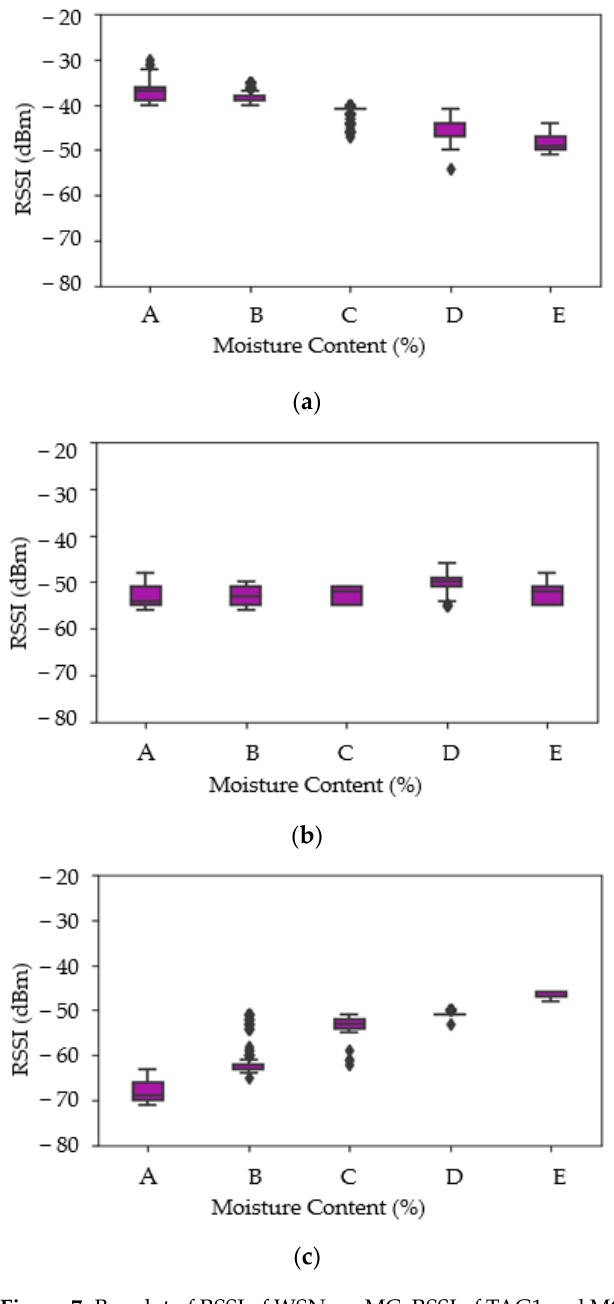
Figure 7. Boxplot of RSSI of WSN vs. MC, RSSI of TAG1 and MC, and RSSI of TAG2 and MC. ( a ) RSSI of WSN vs. MC. ( b ) RSSI of TAG1 vs. MC. ( c ) RSSI of TAG2 vs. MC.